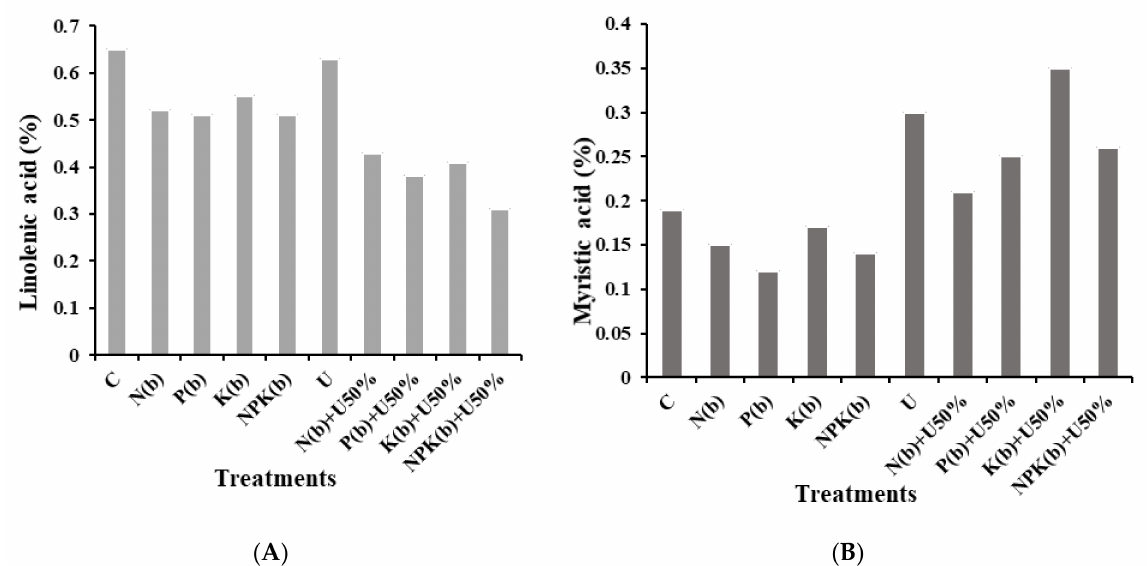
Figure 4. Means comparison for myristic acid ( A ) and linolenic acid ( B ) of Nigella sativa L. as influenced by biofertilizers and chemical urea (chemical urea fertilizer (U), biofertilizer N (b) , biofertilizer P (b) , biofertilizer K (b) , mixed biofertilizer NPK (b) , 50% urea + biofertilizer N (N (b) + U 50% ), 50% urea + biofertilizer P (P (b) + U 50% ), 50% urea + biofertilizer K (K (b) + U 50% ), and 50% urea + biofertilizer NPK (NPK (b) + U 50%